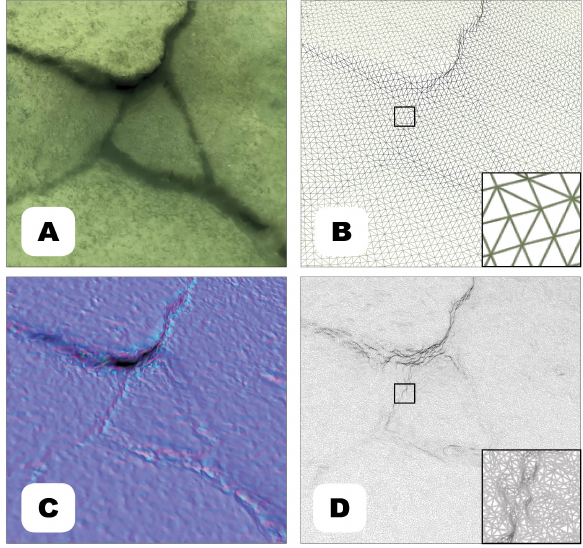
Figure 11. (A) Diffuse Texture (B) Retopologized Mesh (C) Normal